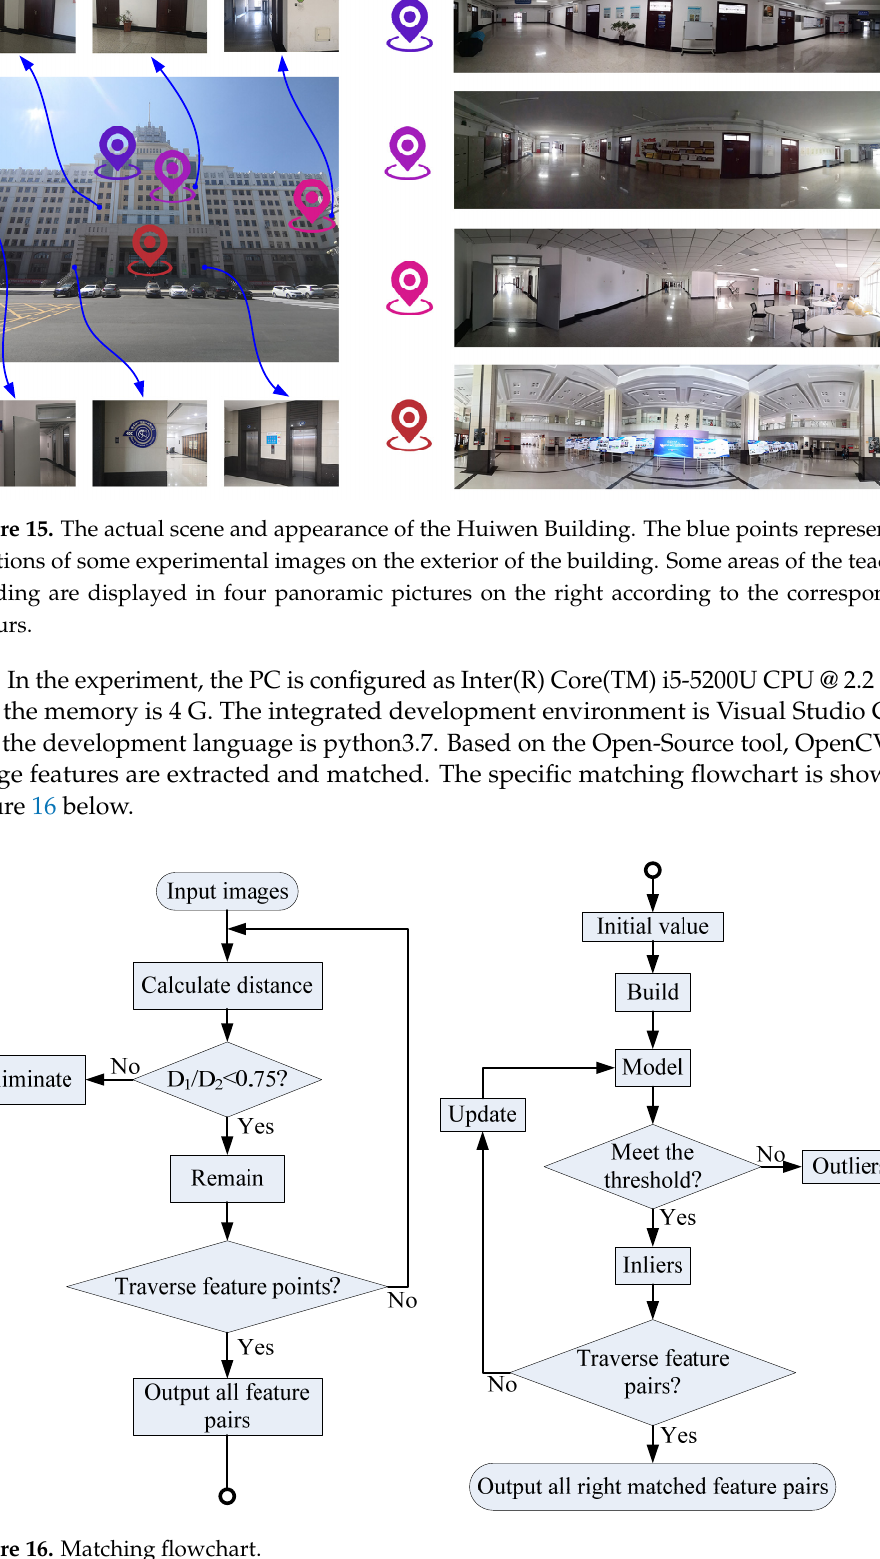
( b ) Figure 14. ARAC background feature extraction. The uniformly distributed circles of various colours in the background area represent the feature points extracted in this area: ( a ) origin background image; ( b ) background feature extracted by ARAC. 4. Match Test and Performance Analysis 4.1. Match Condition Construction When students have classes, take large exams, listen to lectures, and participate in conferences, indoor navigation with high real-time performance is required. In the actual navigation process, we often encounter scenes with strong background consistency such as corridors and stairwells, or indoor environments with many rooms such as teaching buildings, hospitals, science parks, and libraries. Such scenes have fewer feature points and higher similarity, so feature extraction and matching are more difficult. Therefore, we shot in the Huiwen Building of Heilongjiang University whose construction meets the